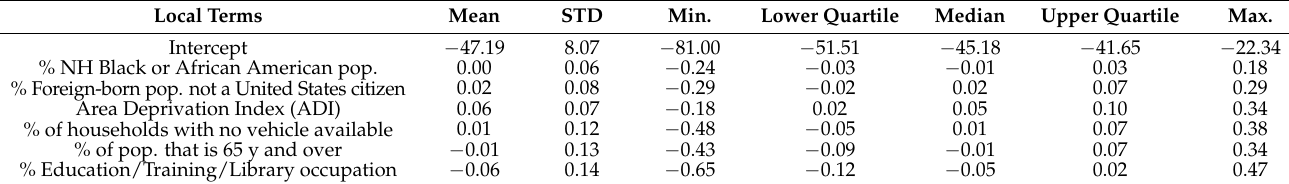
Table 5. Geographically weighted Poisson regression (GWPR) modeling summary